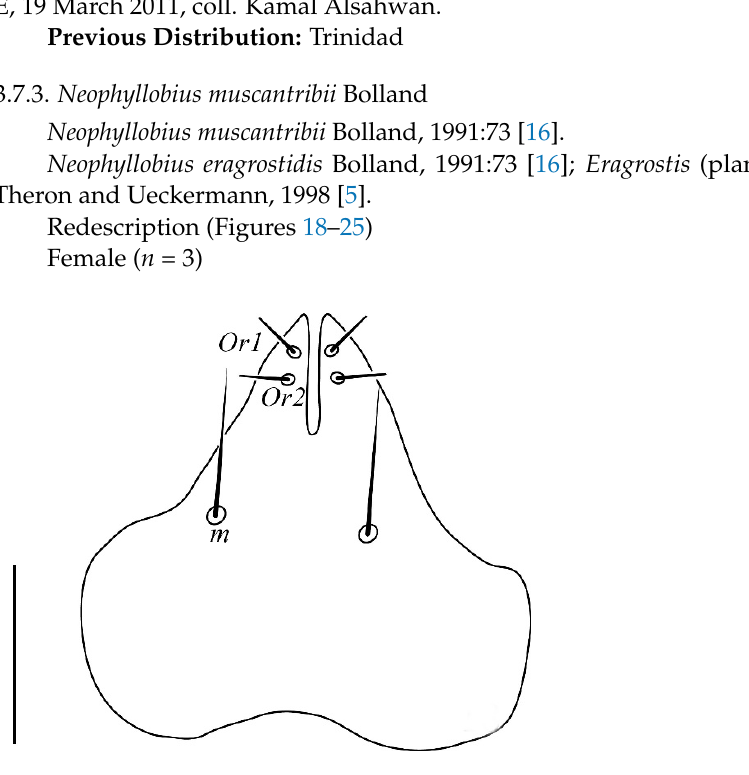
Figure 18. Neophyllobius muscantribii . Female. Gnathosoma. Scale bar: 20 μ m.